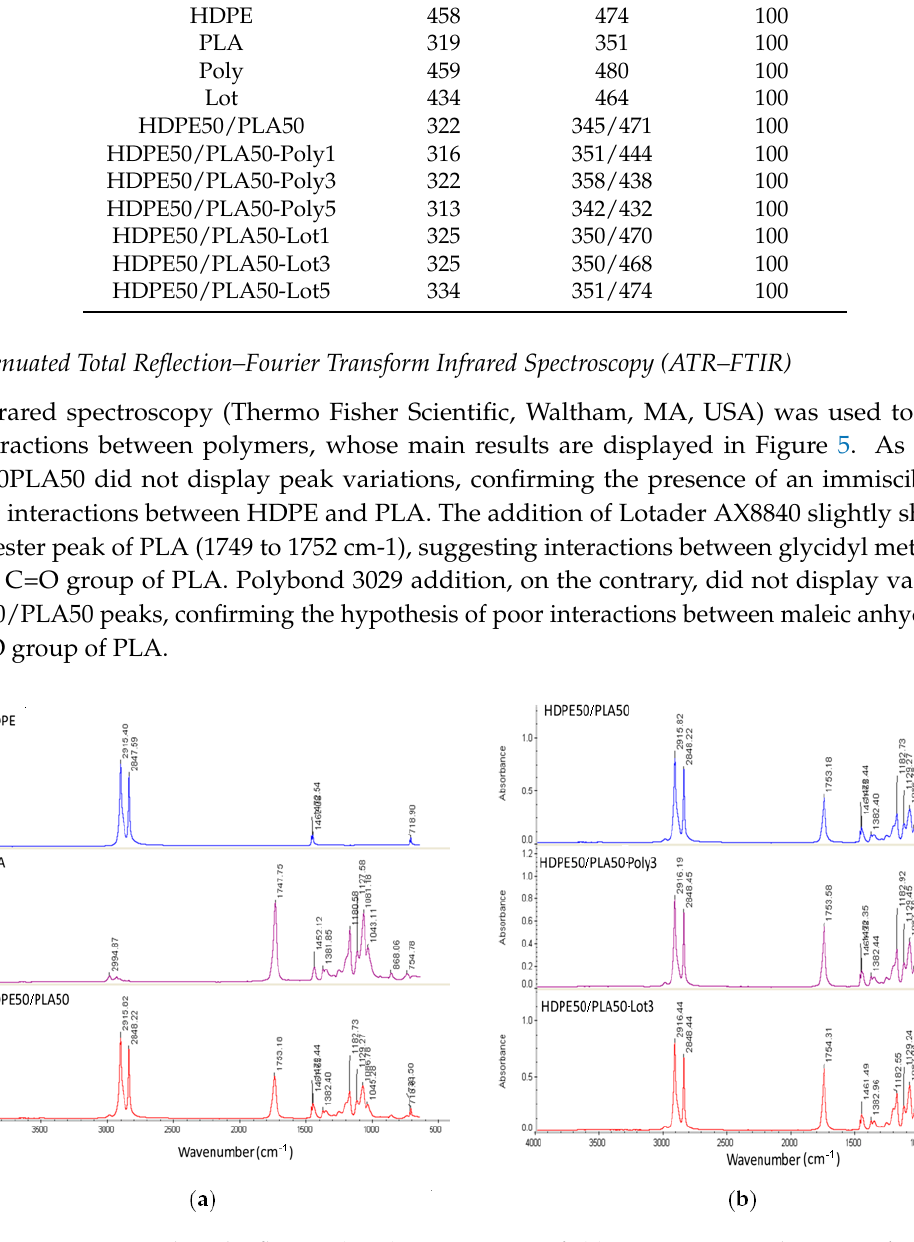
Figure 5. Attenuated total reflection (ATR)–FTIR spectra of: ( a ) HDPE, PLA, and HDPE50/PLA50, ( b ) HDPE50/PLA50, HDPE50/PLA50-Lot3, and HDPE50/PLA50-Poly3.